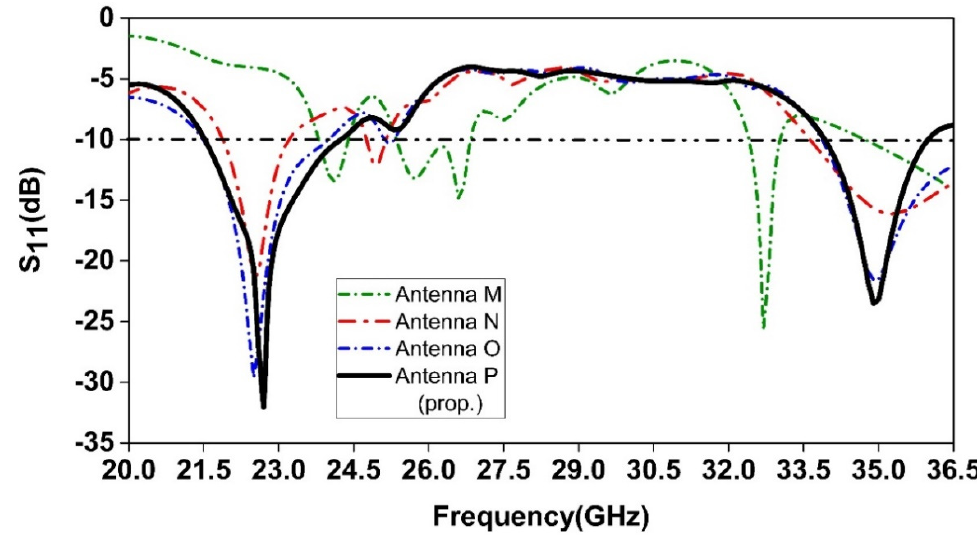
Figure 5. ( a ). The top view of the antenna showing the antenna’s patch array structure, ( b ) the bottom view of the antenna showing the ground plane with the third set of three cuts.